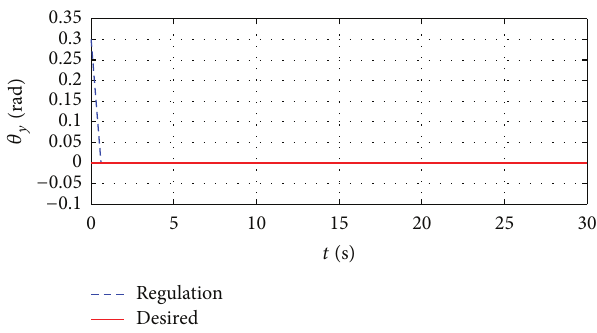
Figure 13: Regulated theta in 𝑦 direction in 30 seconds. Theta in 𝑦 direction, the angle of ball from 𝑦 direction, is stabled after about 0.6 sec.